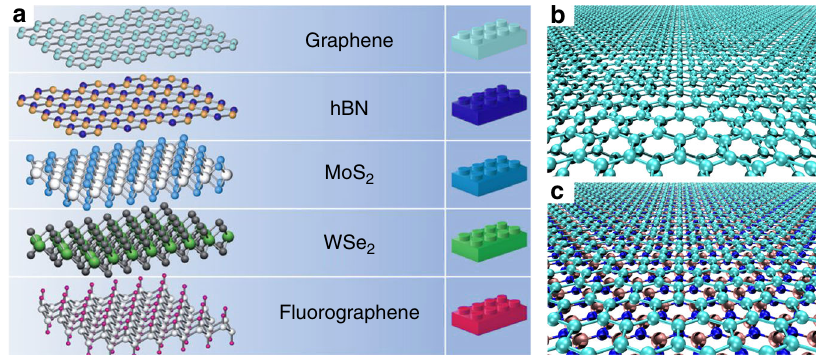
Fig. 3 2D materials as building blocks for clean and atomically fl at mechanical junctions. a Examples of 2D materials used in the construction of layered van der Waals structures (adapted from ref. 61 ). b , c Homogeneous — graphene on graphite — and heterogeneous — graphene on hexagonal boron nitride — interface junctions, respectively, characterized by weakly coupled and extremely stiff atomic layers, and thus exploited for mechanical and tribological applications. While structural lubricity requires an angular misalignment for the homogeneous contact ( b ), the hybrid junction ( c ), thanks to the intrinsic lattice incommensurability, ensures superlubric sliding 68 – 70 independently of the surface